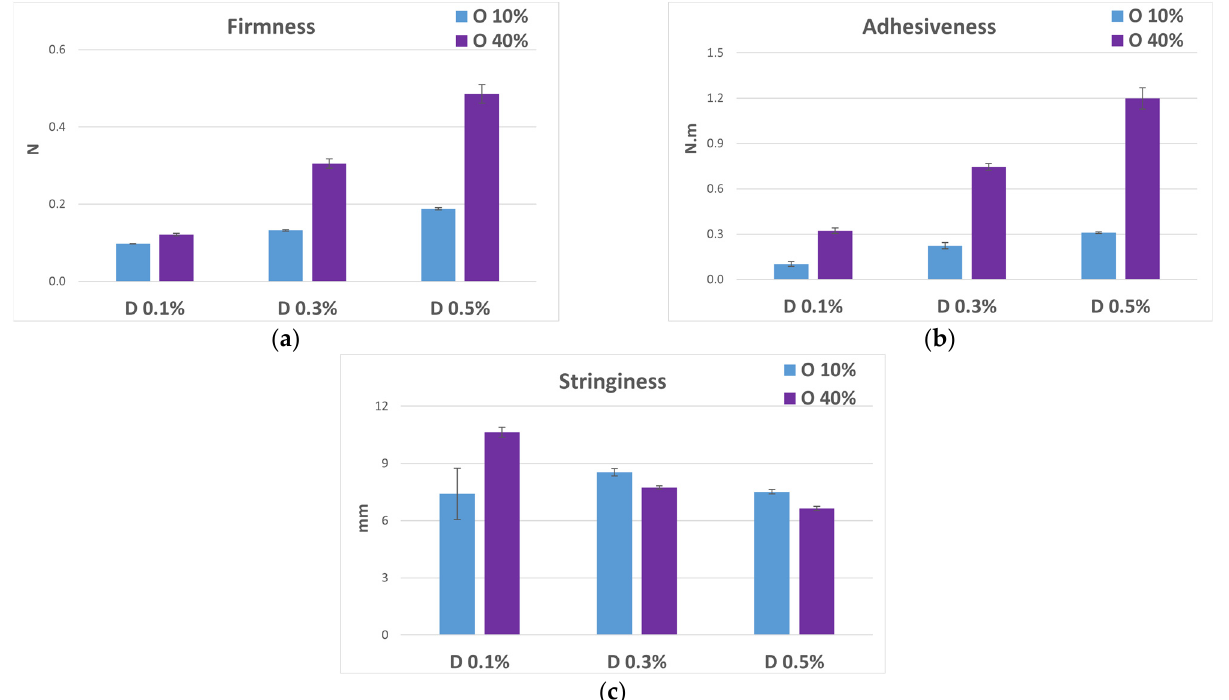
Figure 7. Textural parameters and standard deviations of firmness ( a ), adhesiveness ( b ), and stringiness ( c ) measured by an immersion/de-immersion test for the emulsions prepared with A-Z associations (1:1), D at increasing concentrations (0.1–0.3–0.5% w/w) with 10% w/w (blue columns) and 40% w/w (purple columns) of oily phase O. Table 4. Stability test results of emulsions formulated with 10% w/w of oil phase O, 0.1% w/w of diutan gum D and the different total amounts of solid phase composed by Zea mays starch A and zinc oxide Z (ratio 1:1).